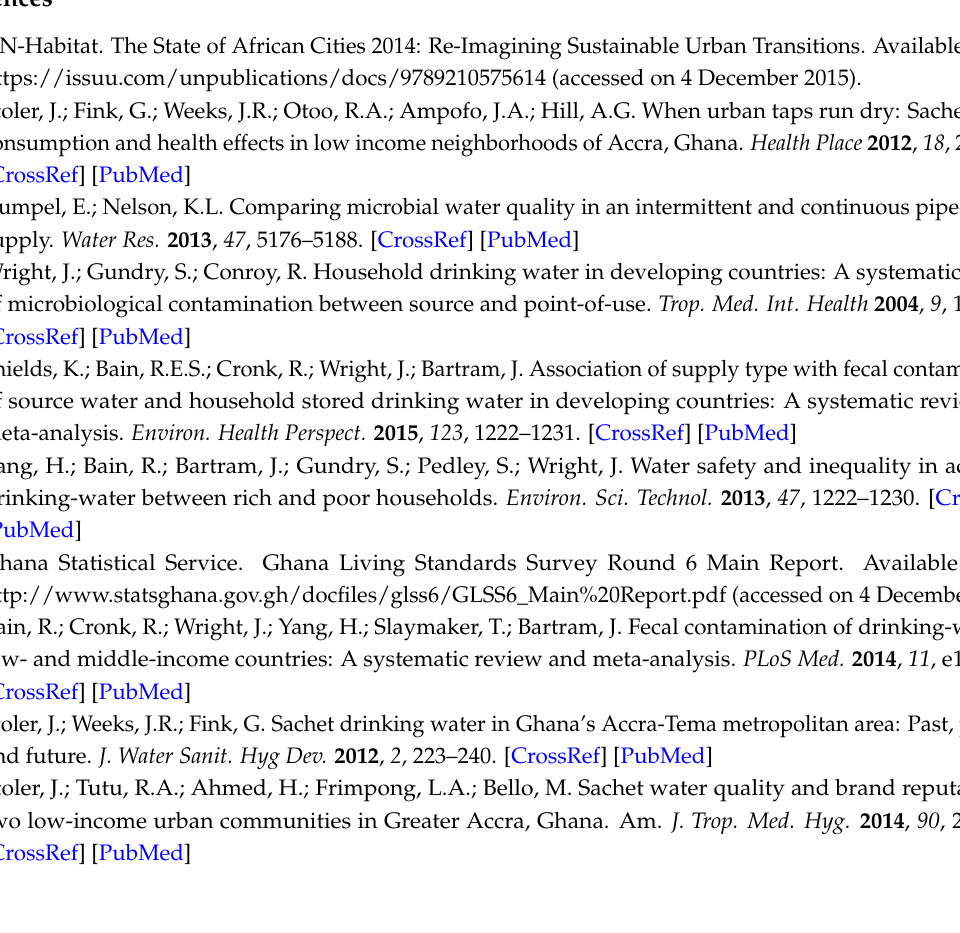
Table S1: Multivariable multinomial regression results, excluding observations with potential errors; Table S2. Descriptive statistics for E. coli contamination of water at the point of consumption, n = 2972. Table S3. Relative risk ratios for low (1 to 12 cfu/100 mL), medium (13 to 72 cfu/100 mL) and high (>72 cfu/100 mL) contamination of water at the point of consumption with E. coli derived from univariable multinomial regression analysis. Table S4. Relative risk ratios for low (1 to 12 cfu/100 mL), medium (13 to 72 cfu/100 mL) and high (>72 cfu/100 mL) contamination of drinking cup water with E. coli derived from multivariable multinomial regression